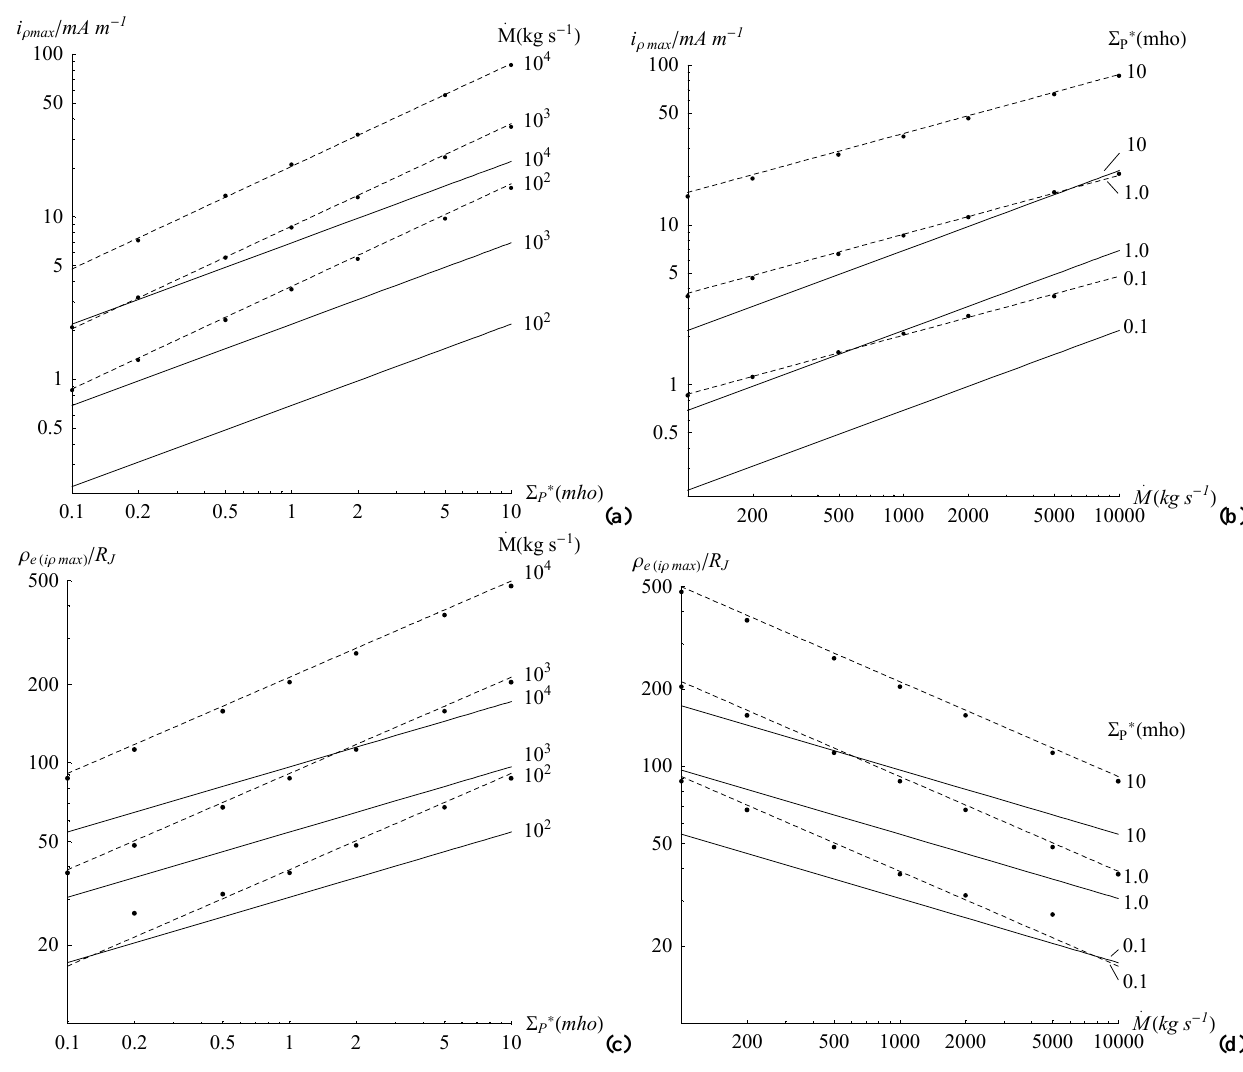
Fig. 10. Plots showing the magnitude and location of the peak sheet-integrated equatorial radial current intensity, and their dependence on 6 ∗ and ˙ M . Plot (a) shows the magnitude of the peak current versus 6 ∗ in log-log format for ˙ M = 100, 1000 and 10000kgs − 1 , while plot P P (c) shows the corresponding equatorial location of the peak in a similar format. Plots (b) and (d) similarly show the magnitude and location = 0 . 1, 1 and 10mho. Solid lines give results for the dipole field obtained from Eq. (21c), while the of the peak current versus ˙ M for 6 ∗ P dashed lines show corresponding results derived from the approximate solutions for the power law current sheet model given by Eq. (34c). The solid dots show spot values obtained from numerical integration of the full current sheet